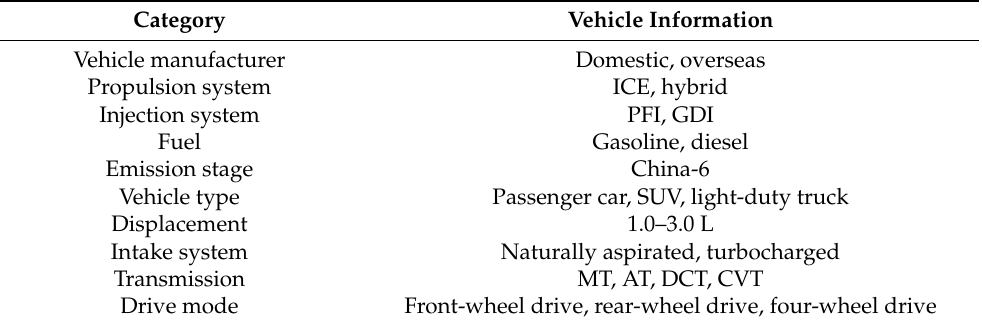
Table 1. Vehicle